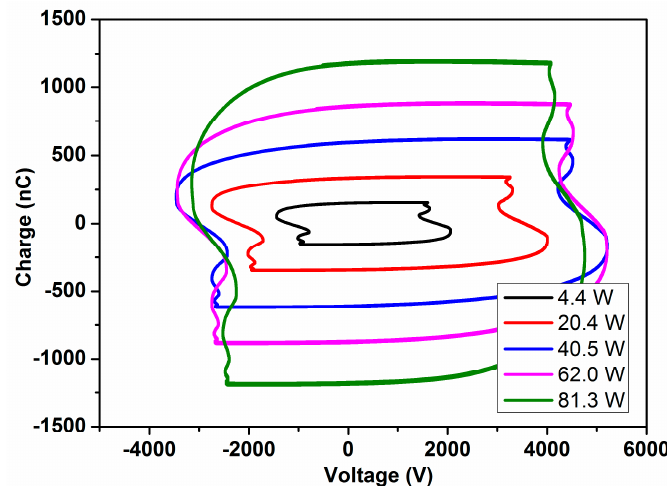
Figure 5. Set of Lissajous curves recorded when activating the NH 3 /D 2 /N 2 at increasing